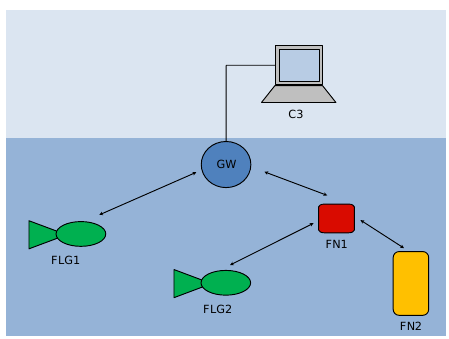
Figure 8. The test-bed.